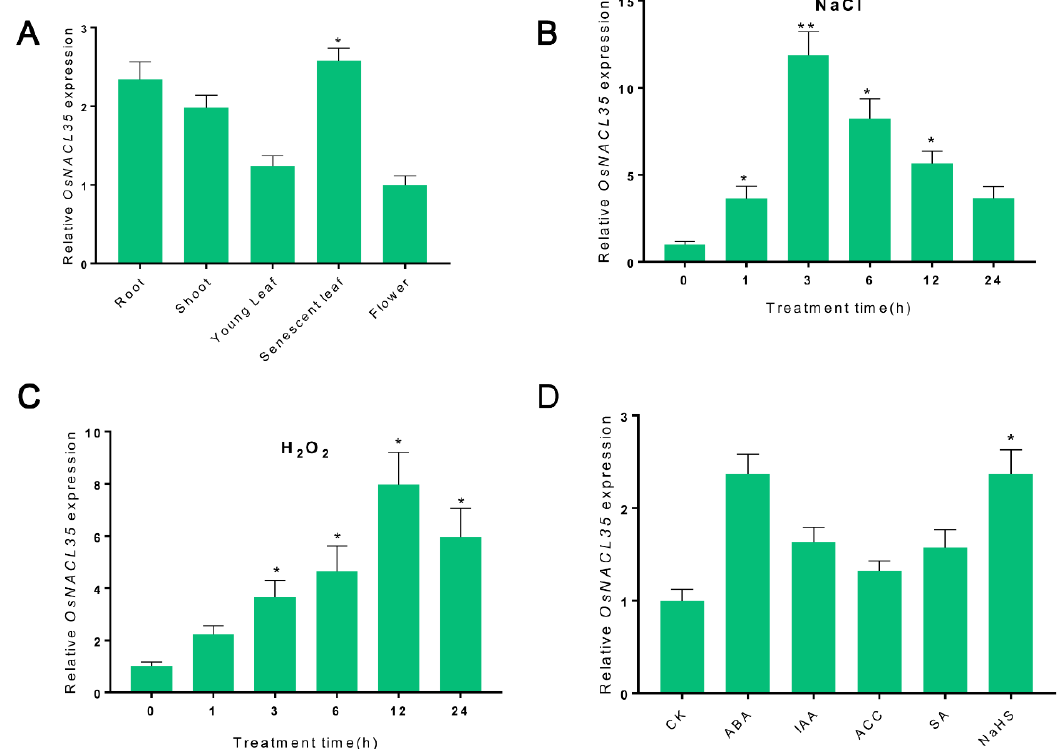
Figure 3. Expression patterns of OsNACL35 in SR86. ( A ) Expression profiles of OsNACL35 in different tissues of SR86. Data were normalized against the flower sample. ( B , C ) Time course of the OsNACL35 transcript level under salt stress and H2O2 treatment. Relative expression was calculated against the expression level at 0 h. ( D ) Expression profiles of OsNACL35 upon different hormone and NaHS treatments. The expression level in CK was calculated as reference. The values are means ± SD of three biological replicates. Asterisks indicate statistically significant differences (* p < 0.05, ** p < 0.01) from the control check (CK).